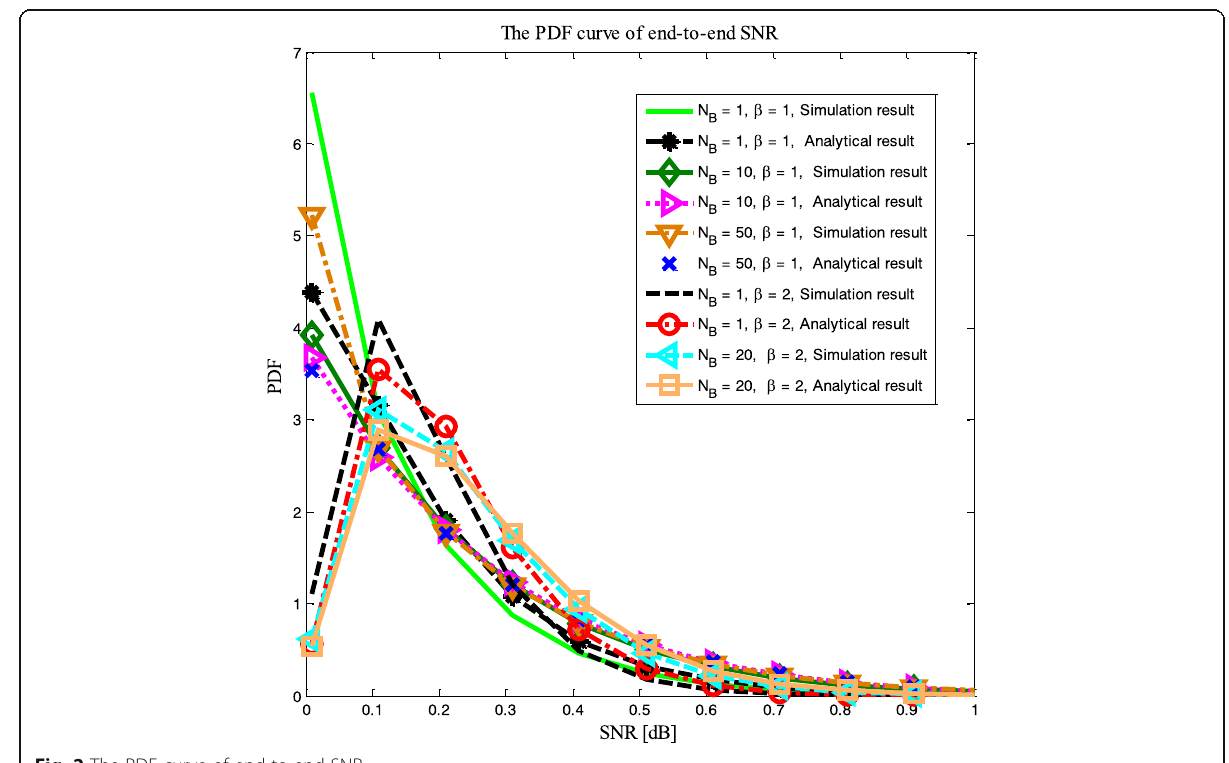
Fig. 2 The PDF curve of end-to-end